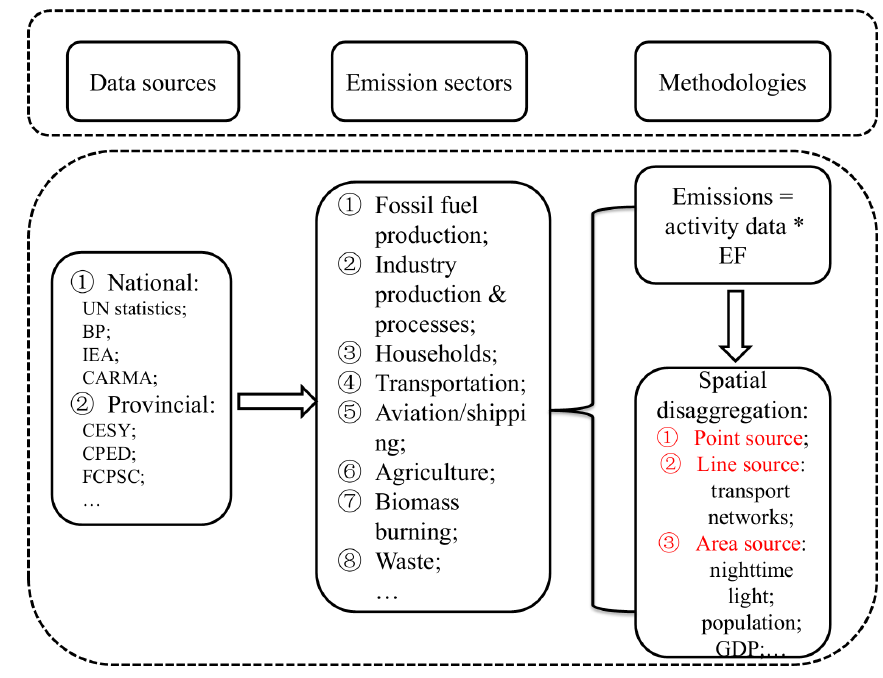
Figure 1. Conceptual diagram for data evaluation based on data sources, emission sectors, and